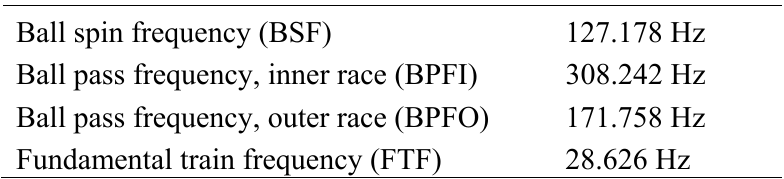
Table 2. The bearing characteristic frequencies.